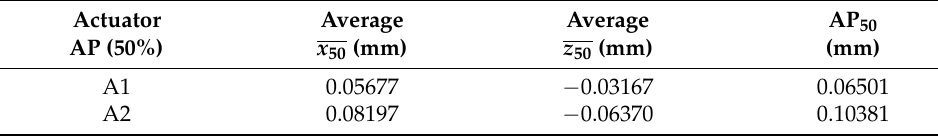
Table 3. Calculated AP 50 values for actuators under half the load.